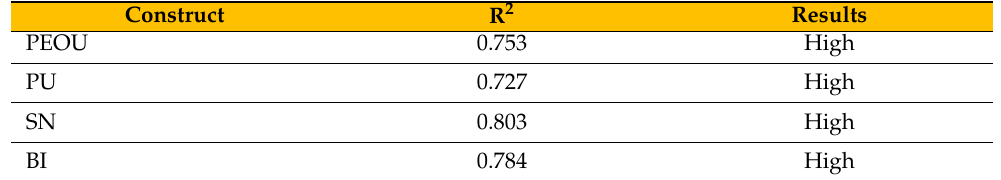
Figure 2. Path coefficient of the model (significant at p ** < = 0.01, p * < 0.05). Table 6. R 2 of the endogenous latent variables.